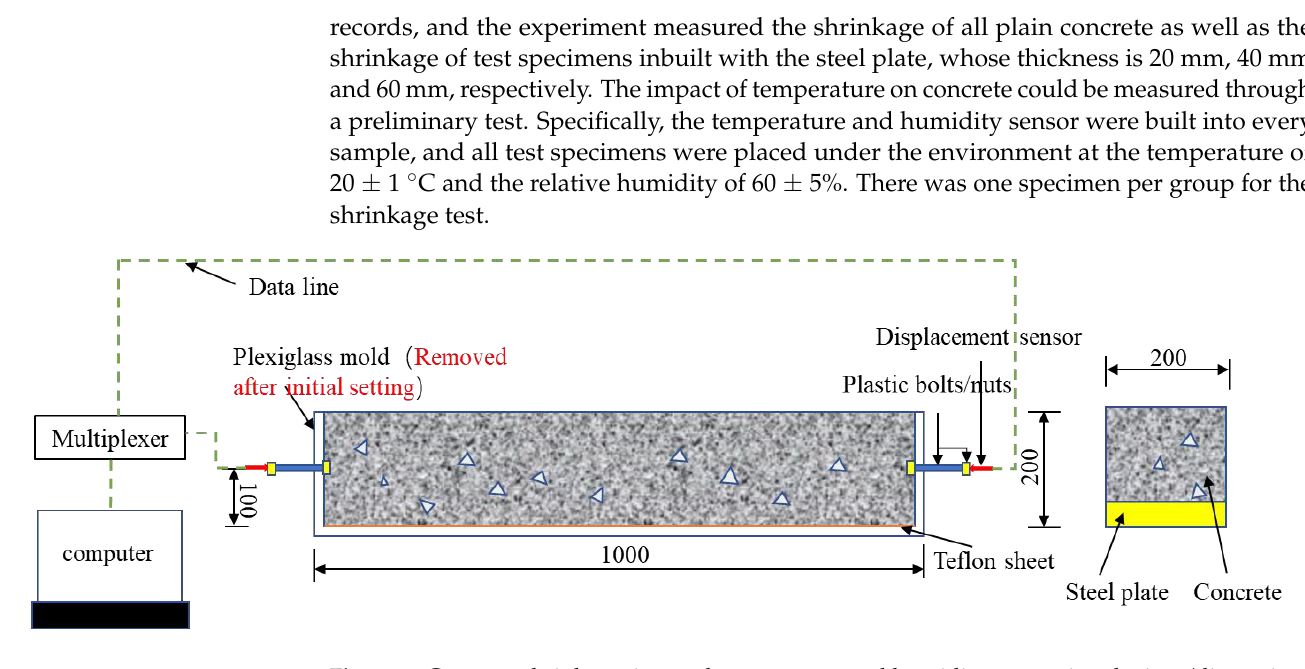
Figure 4. Concrete shrinkage, internal temperature and humidity measuring devices (dimensions in mm).